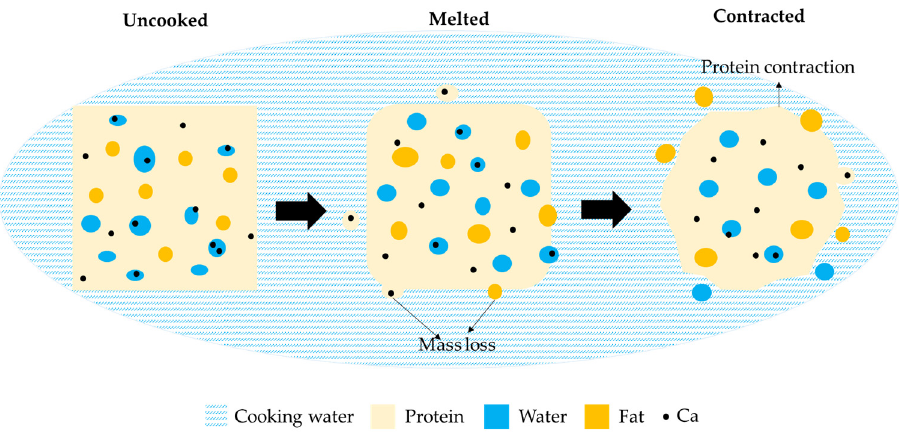
Figure 10. Schematic model proposed for kinetics of mass transfer during cooking of cheese curd.